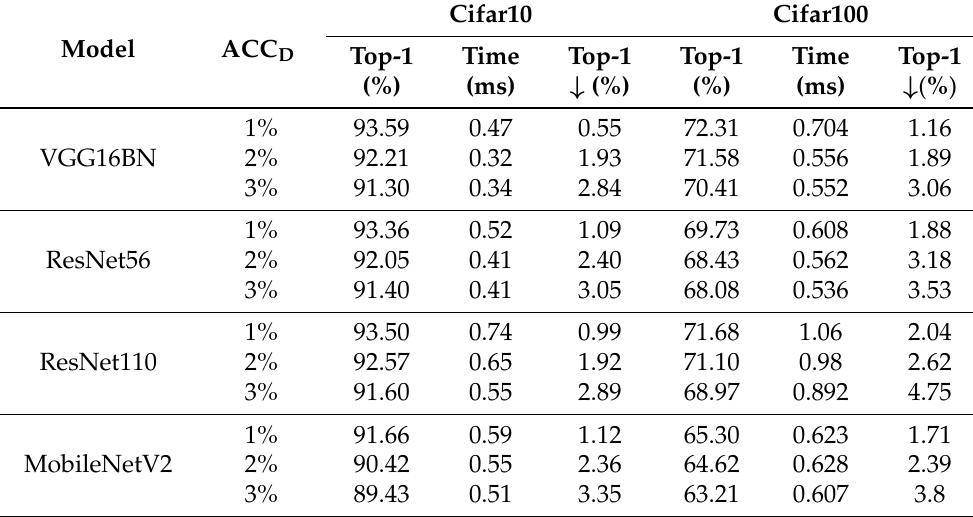
Table 6. Implementation results of the pruned models on the